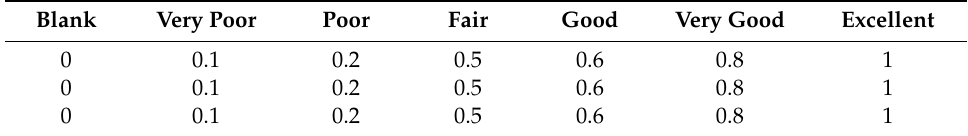
Table 2. The parameter linguistic variables and memberships.